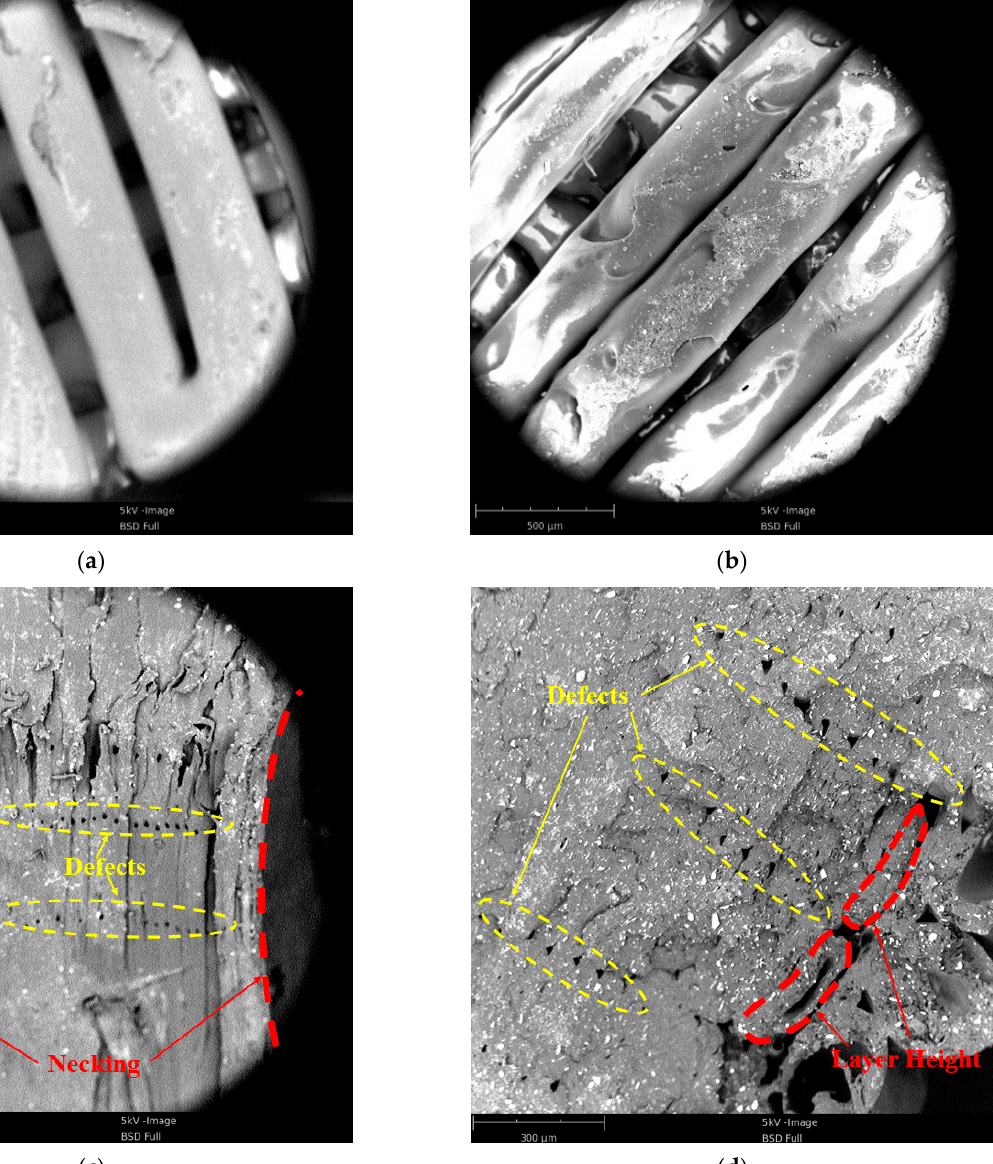
Figure 9. SEM images of 3D printed sample. ( a ) PLA sample surface; ( b ) PLA ‐ Cu sample surface; ( c ) cross section of PLA sample; ( d ) cross section of PLA ‐ Cu sample. sample; ( d ) cross section of PLA-Cu